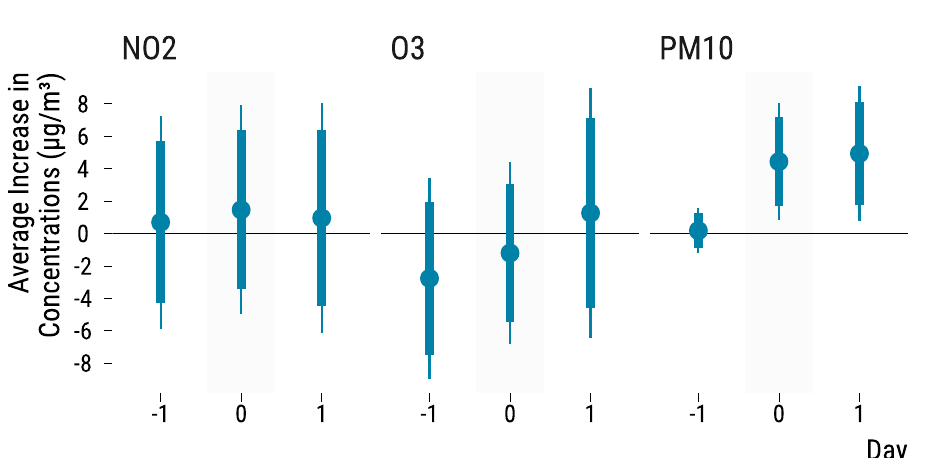
Figure 5. Effects of North-East winds on air pollutant concentrations . In each panel, we plot the estimated effects of North-East winds on air pollutant concentrations for the previous, current and following days. Point estimates are depicted by blue points; blue thick lines are 95% confidence intervals and thin lines are 99% confidence intervals. The 95% and 99% confidence intervals associated with the estimated average